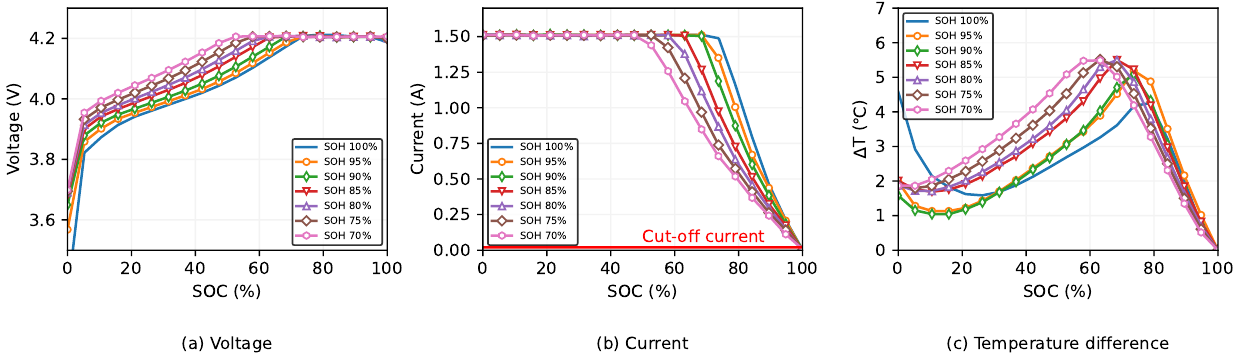
Figure 3. Data sampled by constant SOC intervals during charging of battery #5.